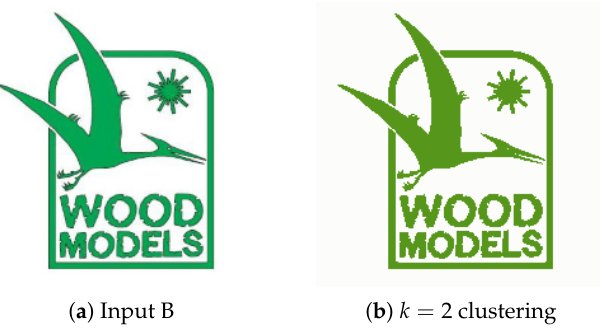
Figure 10. ( a ) Experiment B input; ( b ) Experiment B K-Means clustering ( k =